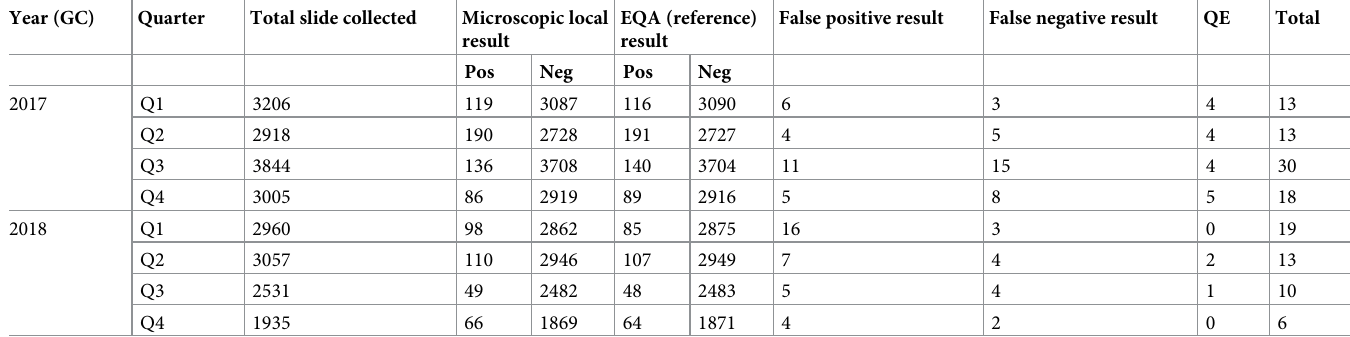
A total of 22,602 negative and 854 positive smear results were reviewed. Of these, 0.48% (122) was found discrepant smear reading error. These error consists of 0.25%, 0.19% and 0.085% for false positive (FP), false negative (FN) and quantification error (QE) respectively. In 2017 year, 0.2% of FP and 0.24% of FN discrepancies were found. Likewise, in 2018 year, a FP of 0.3% and 0.12% of FN discrepant findings were observed. In 2017 year, of the reviewed smears, 0.4% (13), 0.45% (13), 0.78% (30) and 0.6% (18) errors were identified in Q1, Q2, Q3 and Q4 respectively. Likewise, in 2018 year, 0.64% (19), 0.43% (13), 0.49% (10) and 0.3% (6) errors were observed in Q1, Q2, Q3 and Q4 respectively (Table 2). The sensitivity, specificity, PPV, and NPV of the smear readings were 94.9%, 99.5%, Table 2. Number of reviewed smears and trend of false positive and negative errors from January, 2017 to December, 2018 year. Year (GC) Quarter Total slide collected Microscopic local